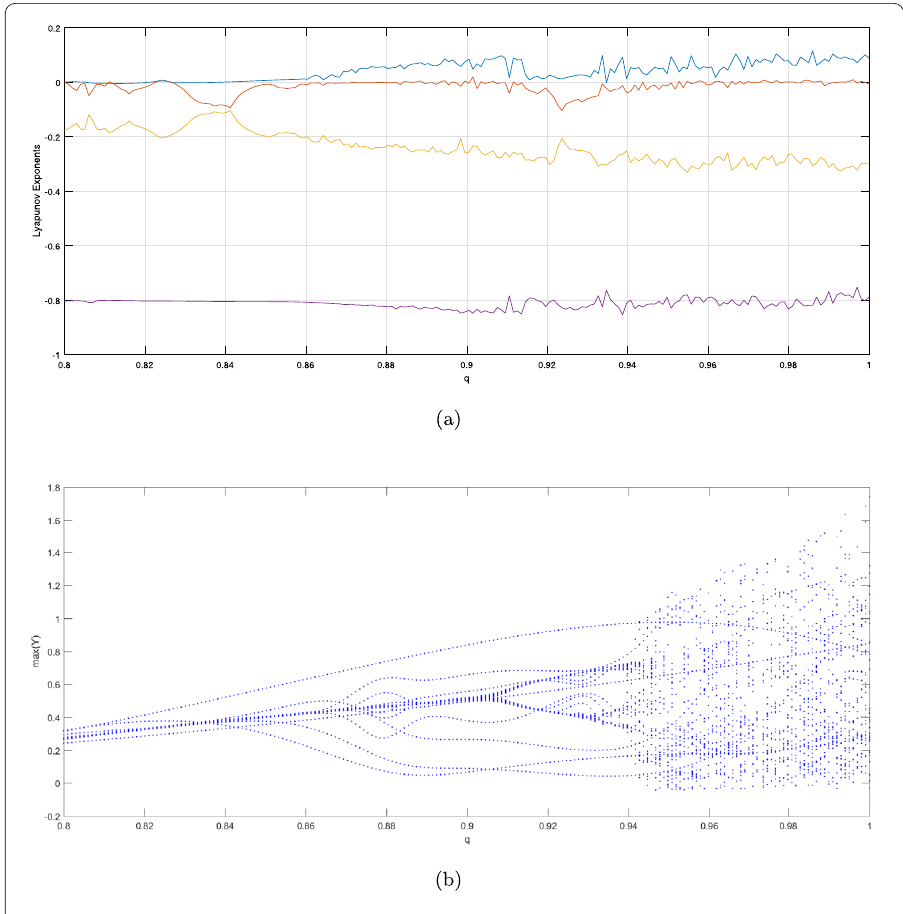
Figure 5 Lyapunov dynamics and bifurcations for varying